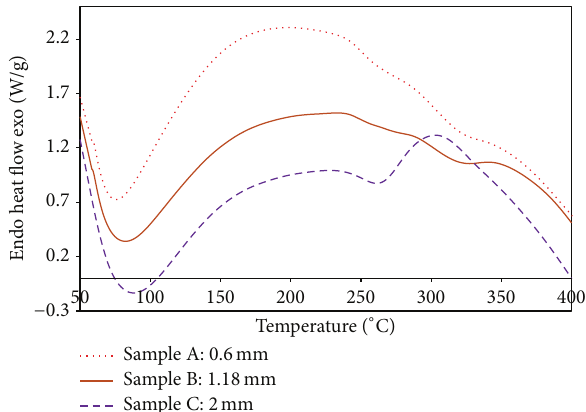
Figure 9: Sago/UF Sample with different size of particle analysis by DSC.